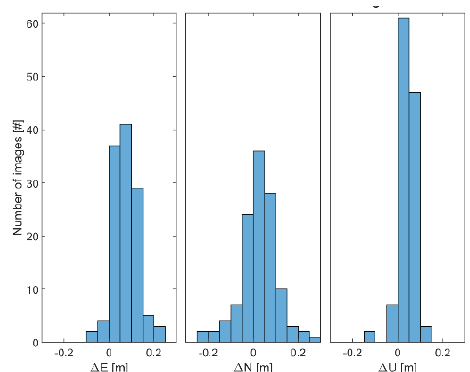
Figure 9. Barplots of the differences between the photogrammetric CPC and the coordinates of APC+ L w after synchronization.